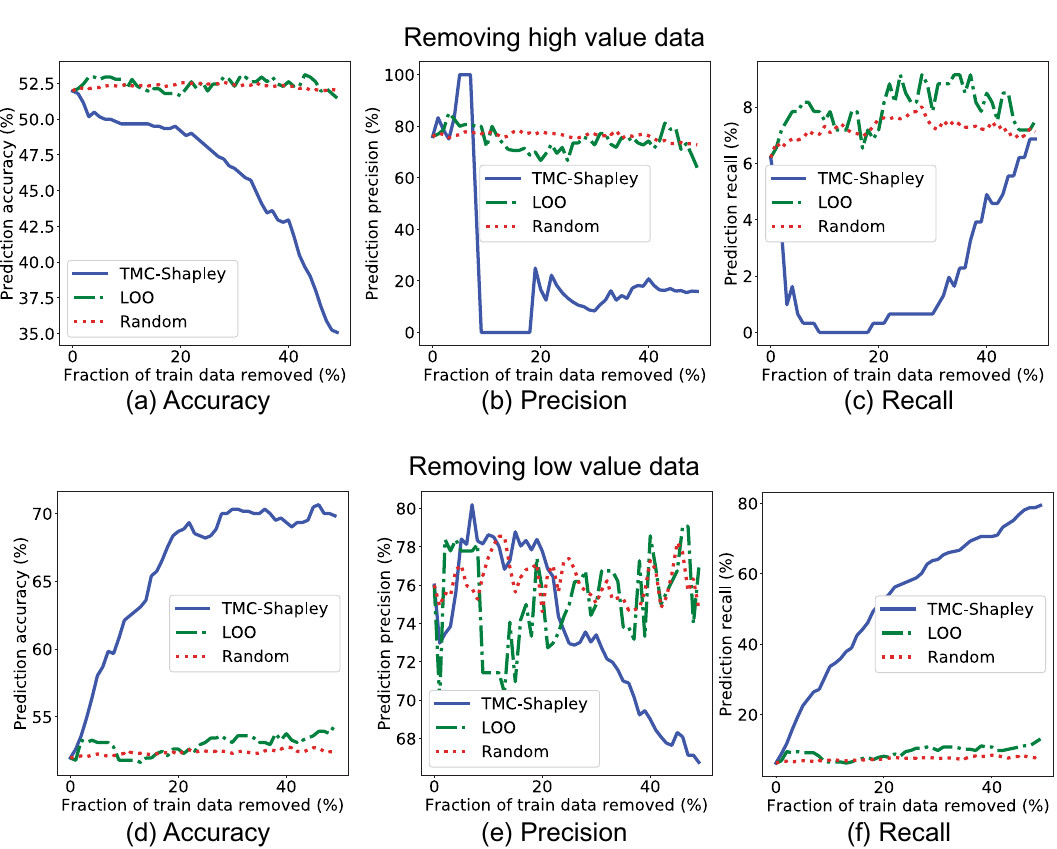
Figure 2. ( a )–( c ) Effects of removing high value data points to pneumonia detection performance. We removed the most valuable data points from the training set, as ranked by TMC-Shapley, leave-one-out (LOO) and uniform sampling (random) methods. We trained a new logistic regression model every time when 1% of the training data points were removed. The x-axis shows the percentage of training data removed, and the